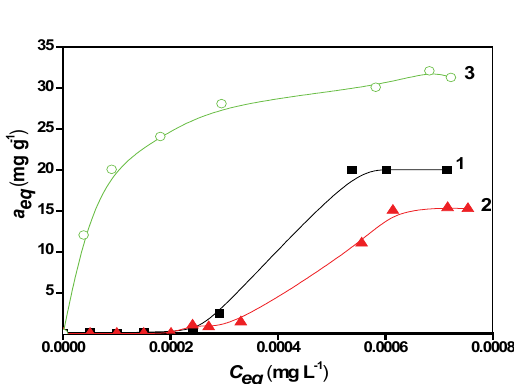
Figure 4. The kinetic curves of mercury(II) adsorption (1–3) in the Lagergren pseudo-first order equation for silicas 1–3 respectively.